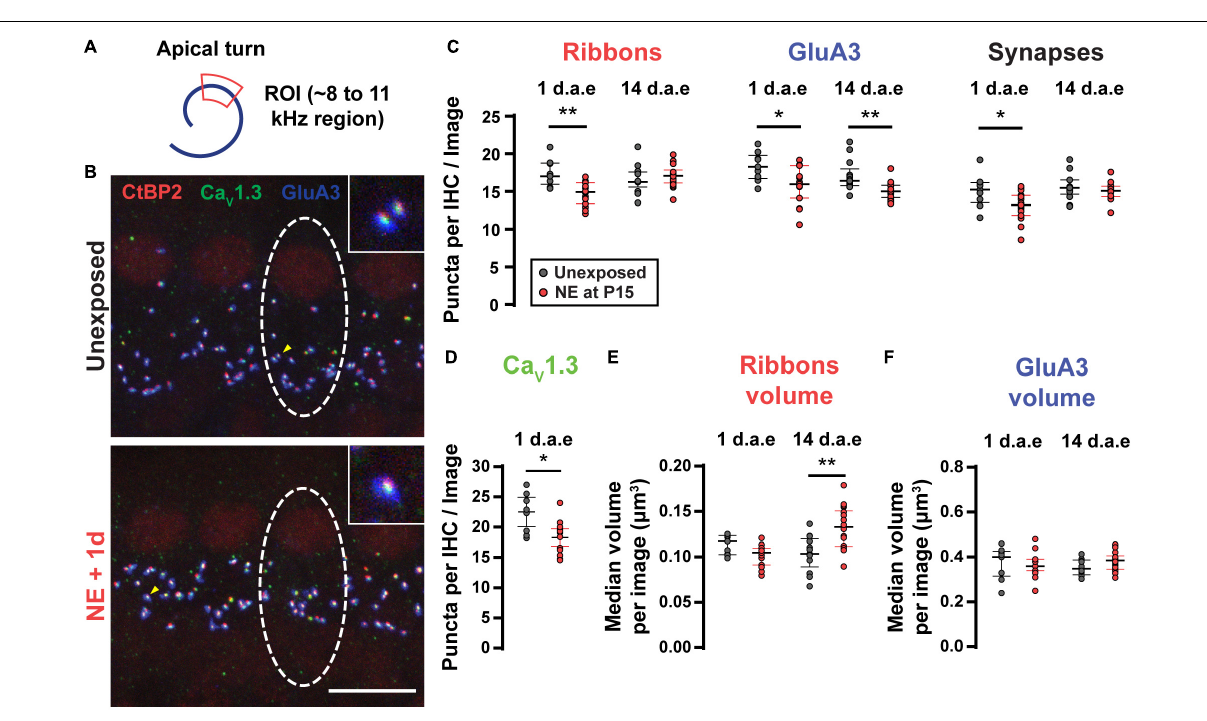
FIGURE 3 | Noise exposure triggered a small but reversible synapse loss and a persistent increase in ribbon volume. (A) Scheme of the apical cochlear turn. Red area indicates the scanned region. (B) Representative images from Unexposed (upper panel) and 1 d.a.e. (lower panel) inner hair cells (IHCs). White dashed lines indicate the approximate contour of one IHC. Scale bar = 10 µ m. (C) Mean number of Ribbons (CtBP2 positive puncta), GluA3 patches and Synapses (double positive puncta) per IHC in each confocal image for cochleae collected 1 and 14 days after exposure at P15 (1 and 14 d.a.e, respectively). (D) Mean number of Ca V 1.3 positive puncta per IHC for unexposed and 1 d.a.e mice. Median volumes per stack for Ribbons (E) and GluA3 (F) for the four experimental groups. Line and whiskers indicate the median and the interquartile range, respectively. * p < 0.05, ** p < 0.01, Mann-Whitney